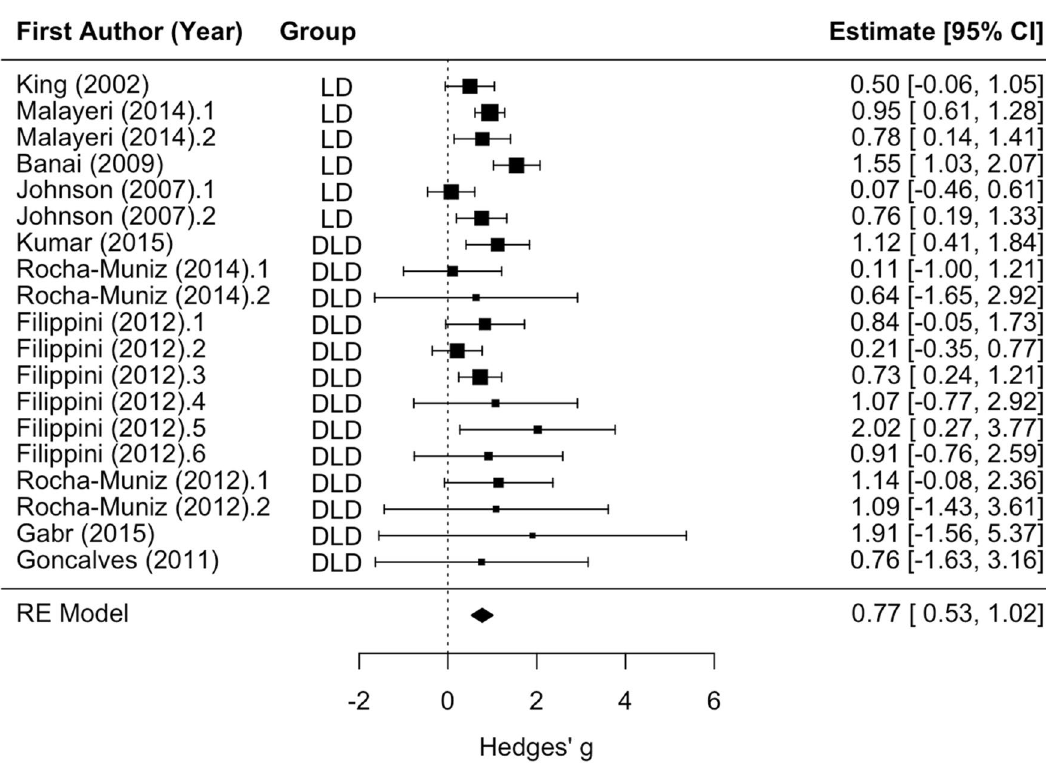
Figure 8. Wave A/Vn latency forest plot. Positive values of Hedges’ g indicate longer latency for the disorder group relative to controls. Rows with decimal points after the article year indicate multiple analyses from the same paper, and correspond to the row order of the analysis in the systematic review table in Supplement